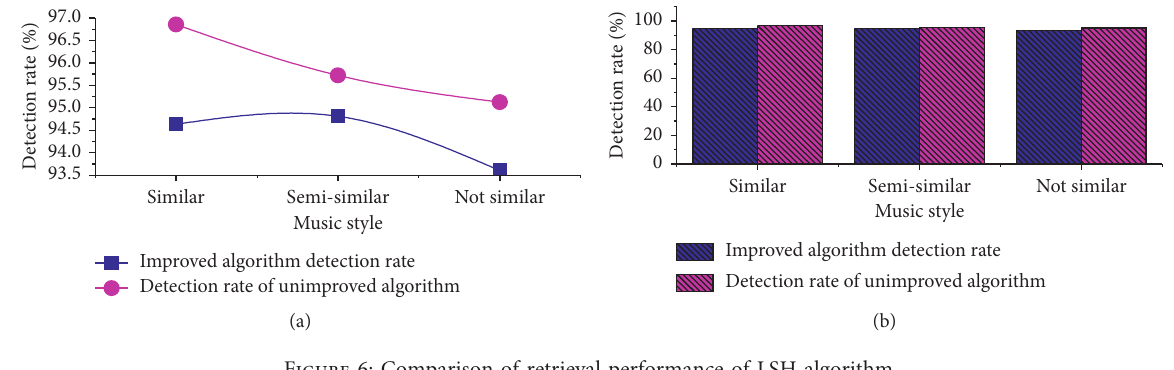
Figure 6: Comparison of retrieval performance of LSH algorithm.